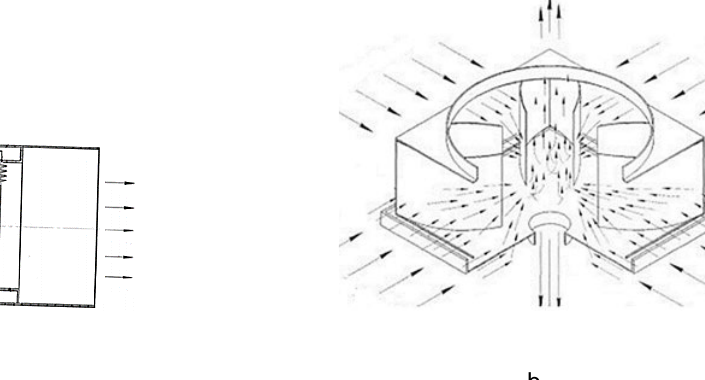
Figure 3. Design schemes for Patents of Ukraine No. 130464 (a), and No. 111039